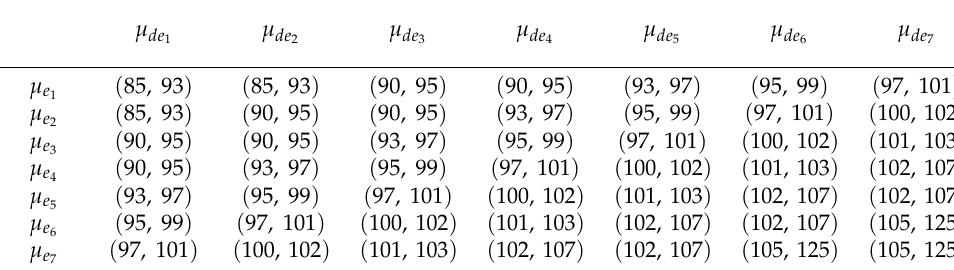
Table 3. Interval Type-2 fuzzy rule table.